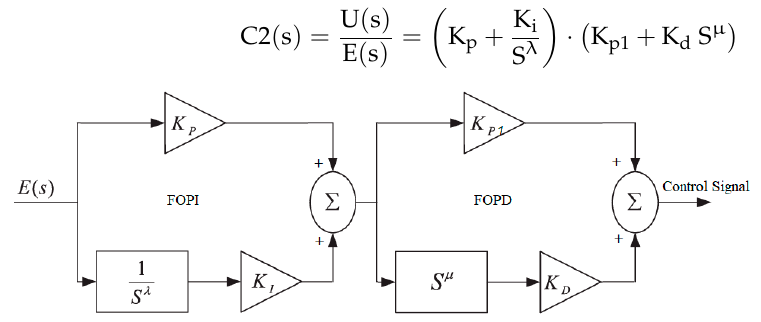
Figure 9. The CFOPID controller structure.